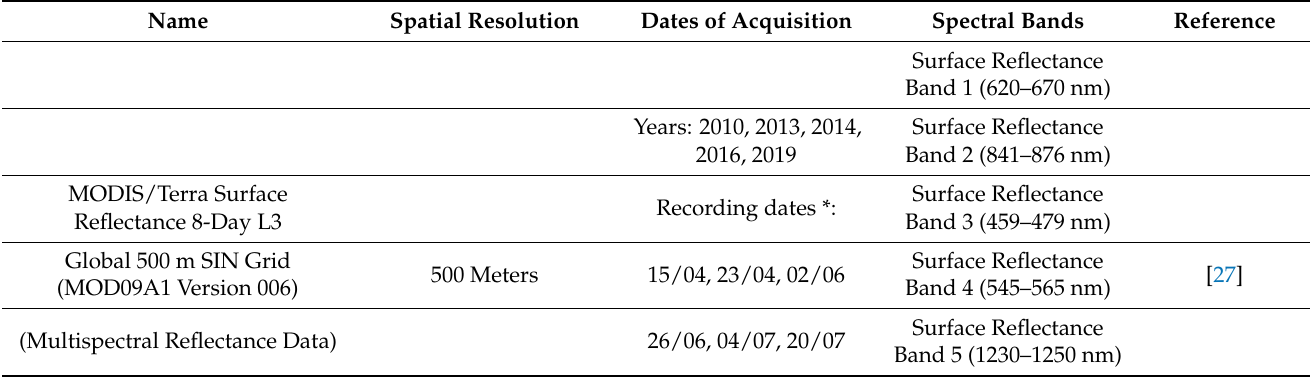
Table 1. Technical parameters of remote sensing and land cover data used in the classification.